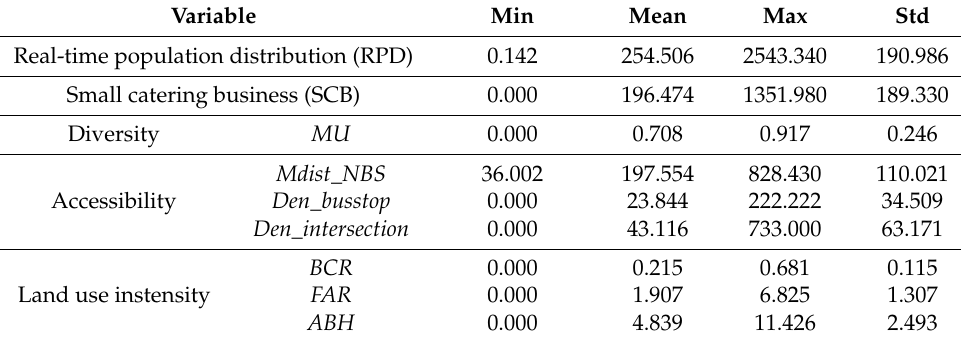
Table 2. Descriptive statistics of